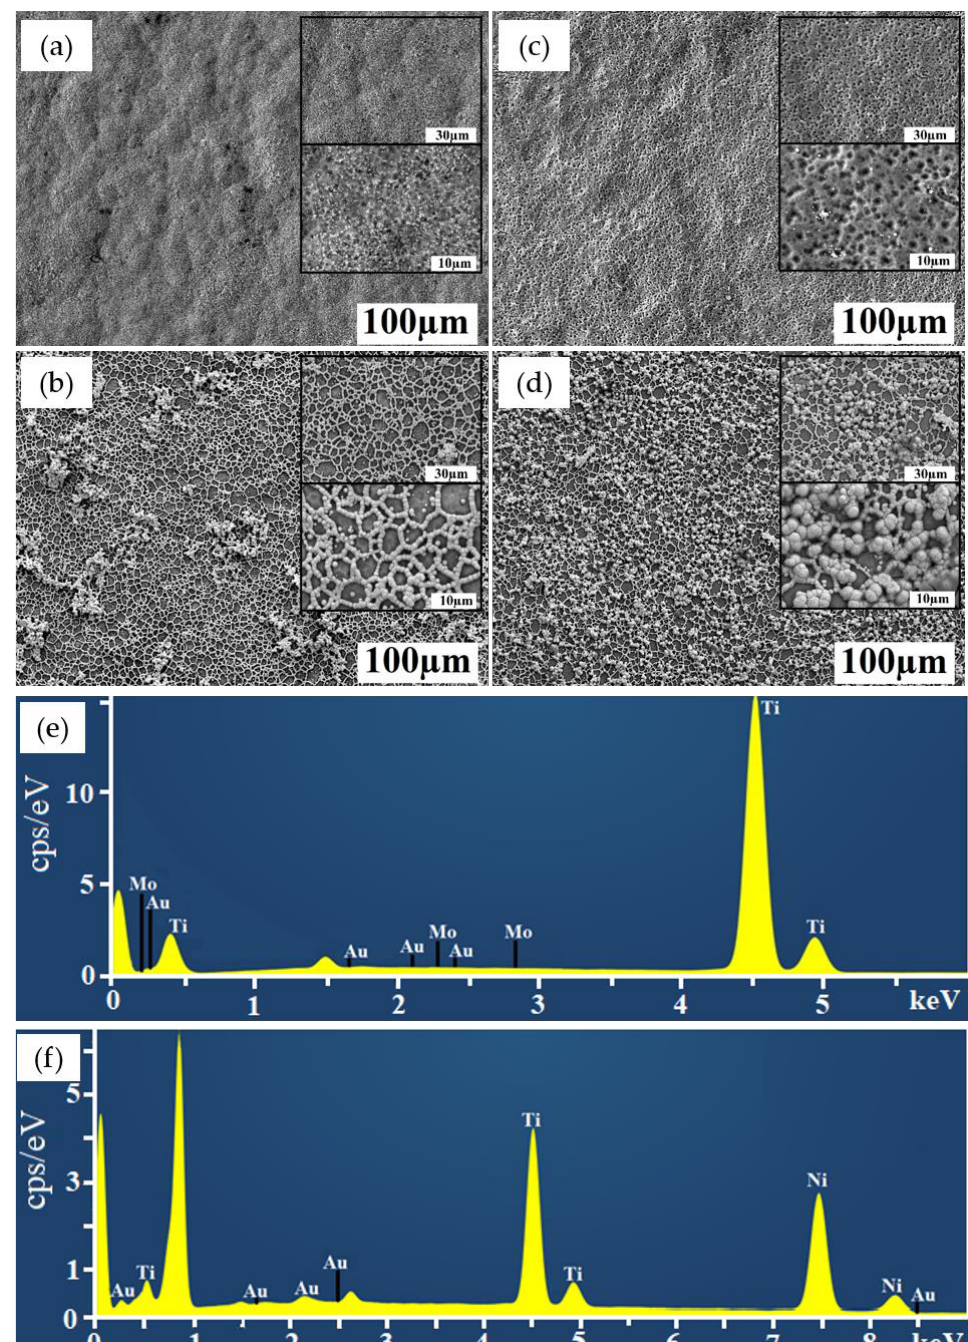
Figure 1. SEM images of Mo/Ti ( a ), Ni/Ti ( b ), Au(Mo)/Ti ( c ), and Au(Ni)/Ti ( d ) coatings. The corresponded EDX spectra of Au(Mo)/Ti ( e ) and Au(Ni)/Ti ( f ) coatings.